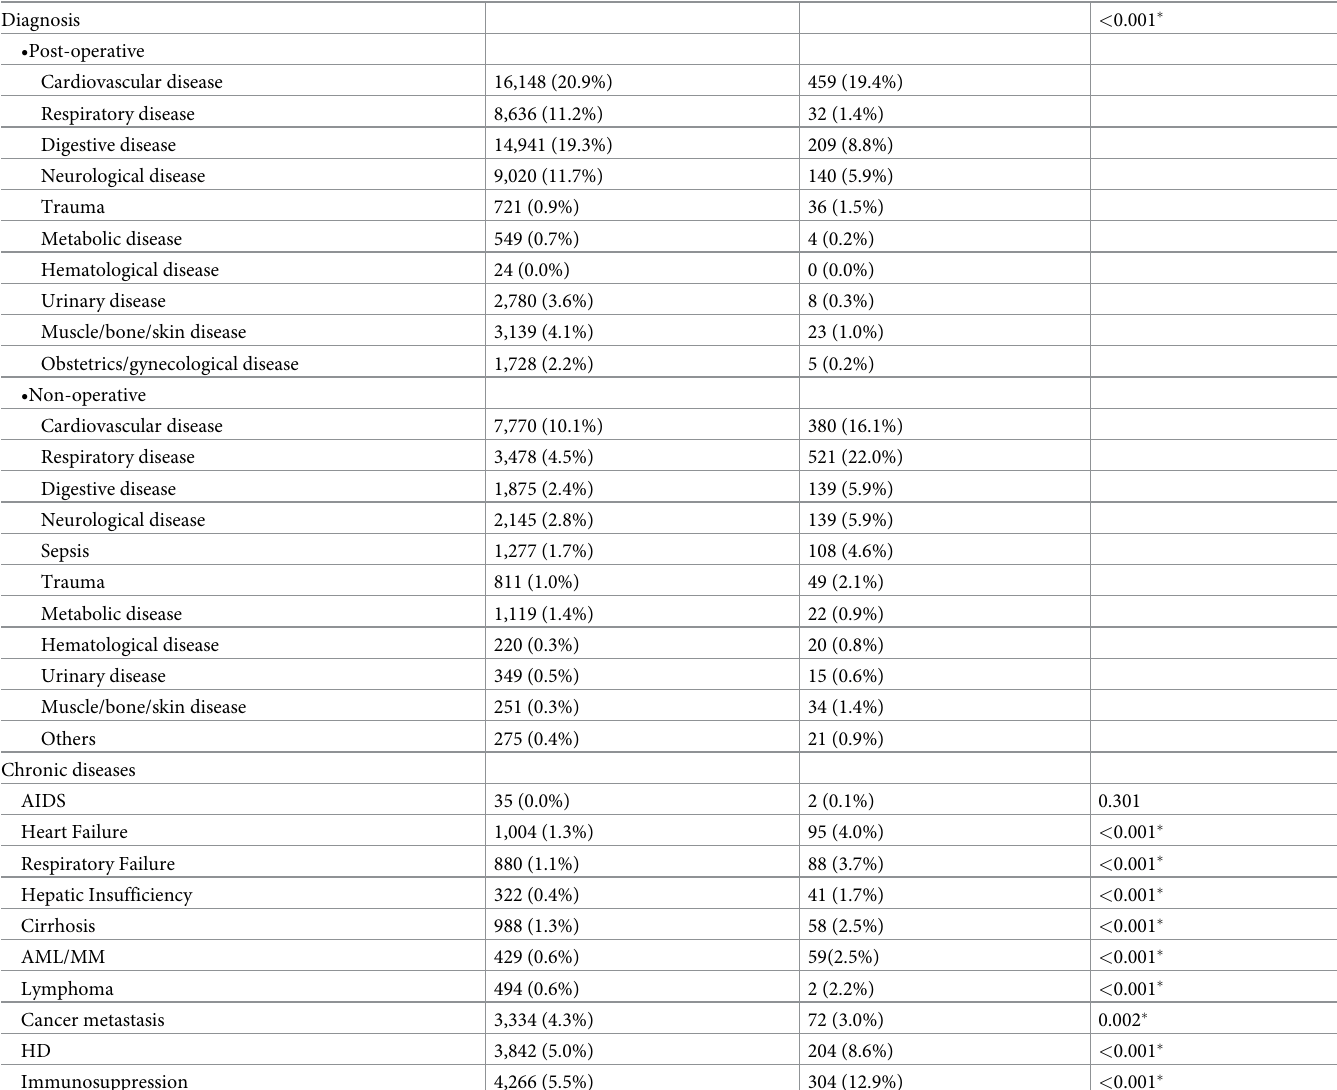
Table 2. Diagnosis and chronic